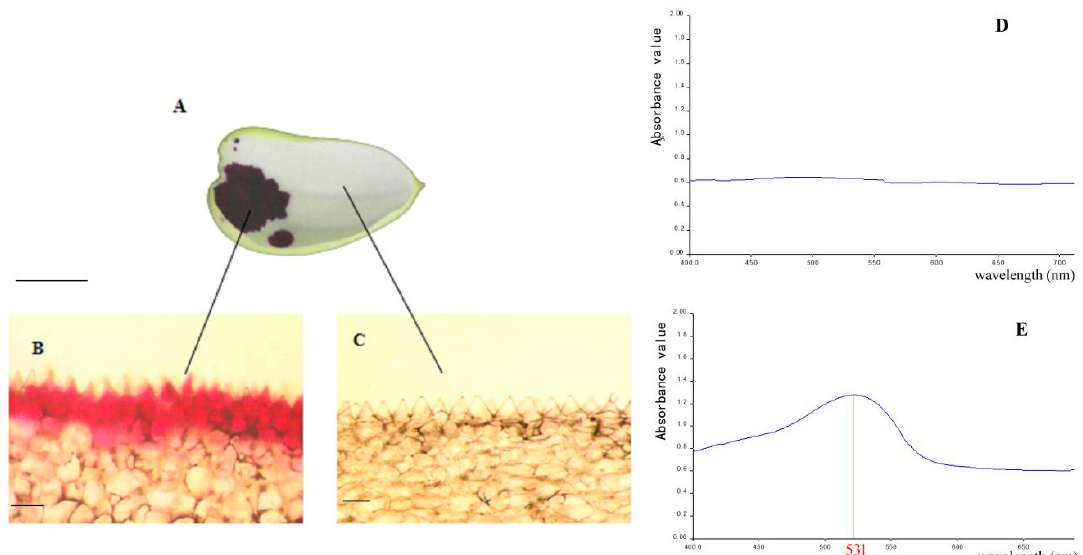
Figure 1. Anatomical structures and anthocyanin content of Phalaenopsis ‘Panda’ sepal. ( A ) Sepal (bar = 1 cm); ( B ) Upper epidermal cell in spot area (bar = 10 µ m); ( C ) Upper epidermal cell in non-spot area (bar = 10 µ m); ( D ) UV-visible spectrophotometer scanning of non-spot area; ( E ) UV-visible spectrophotometer scanning of spot area. Red number of 531 nm represents the absorption wavelength of anthocyanin.